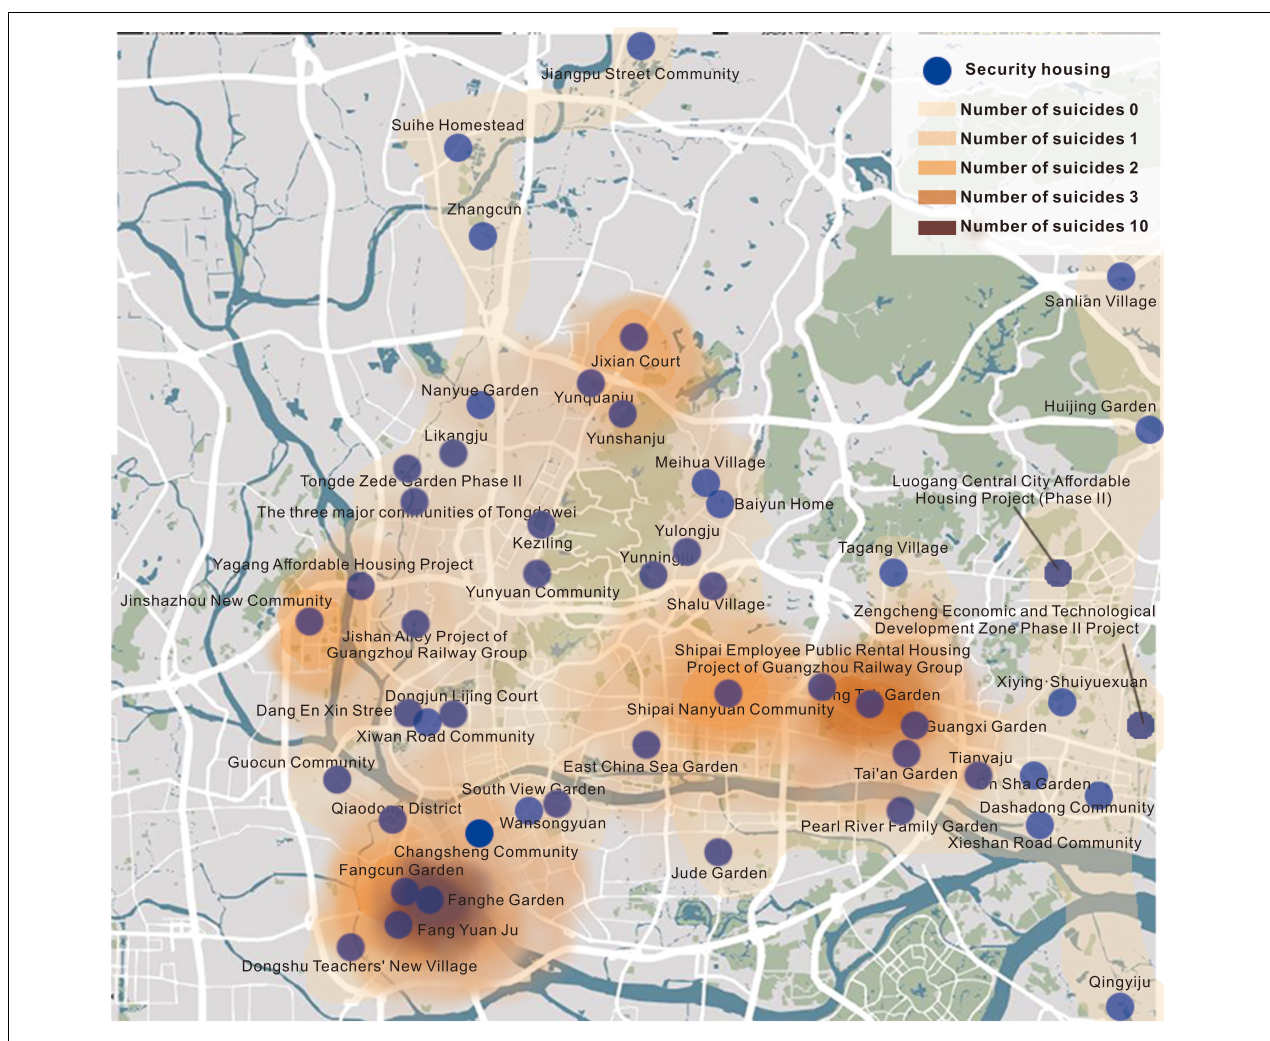
FIGURE 2 | Distribution of suicide rate in affordable housing units in the downtown area of